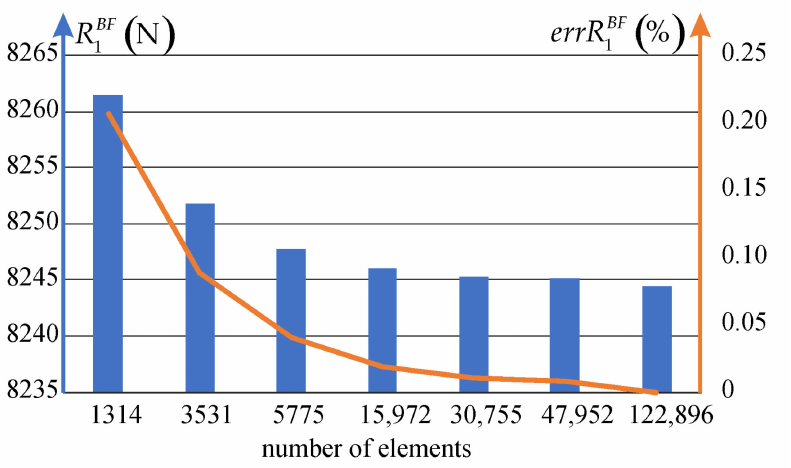
Figure 19. Mesh sensitivity of the FEM solution for the plate